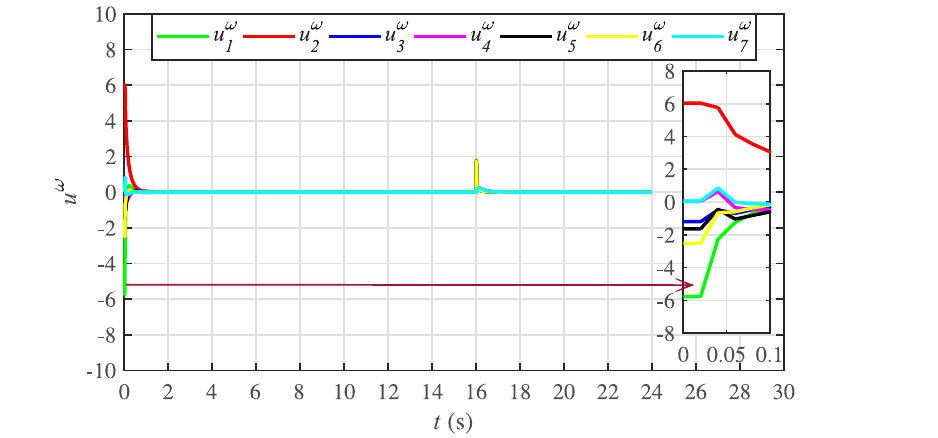
Fig 14. Frequency regulation control efforts under case 1.